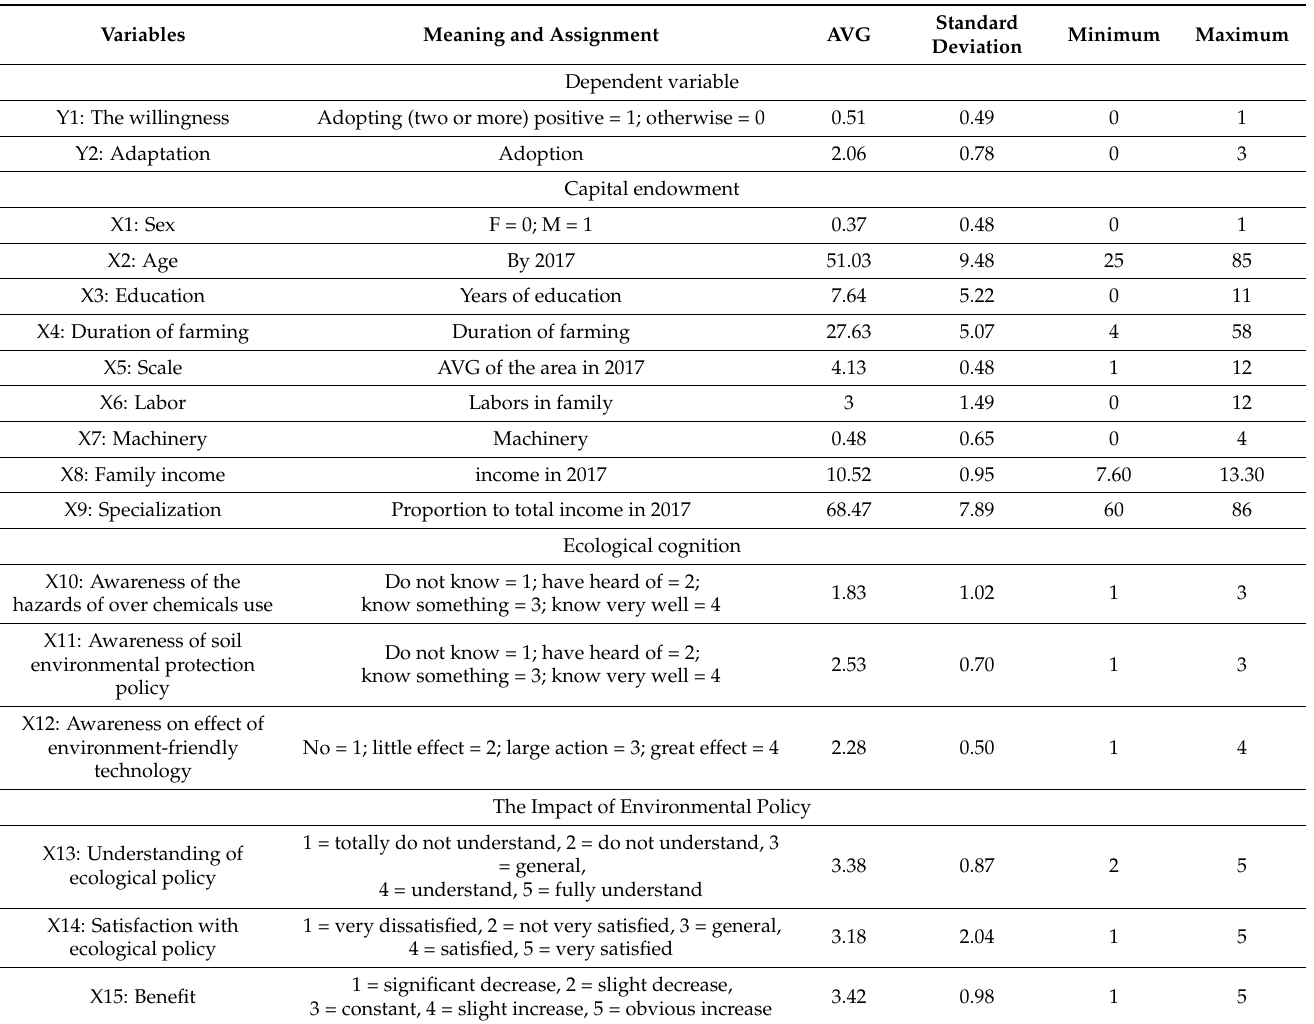
Table 1. Variable definition and descriptive